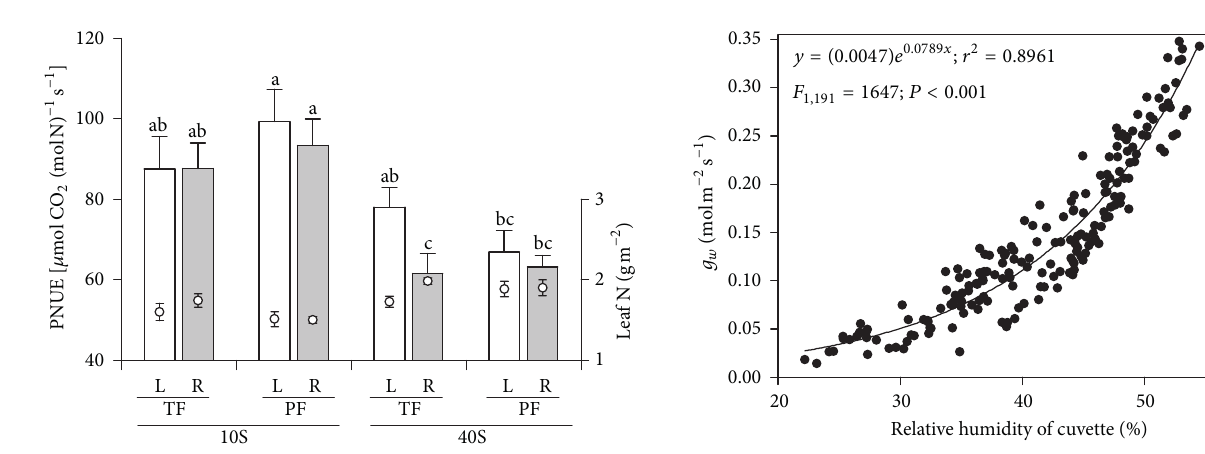
Figure 4: Photosynthetic nitrogen use efficiency (PNUE) and leaf nitrogen (N) concentration of Laguncularia racemosa (L) and Rhi- zophora mangle (R) in response to tidal flooding (TF) or permanent flooding (PF) with 10g/L (10S) or 40 g/L (40S) salinity. Values are means ± 1SE. Effects annotated with the same letter above the bar (for PNUE) indicate lack of significance ( 𝑃 > 0.05 ) after Bonferroni adjustment.